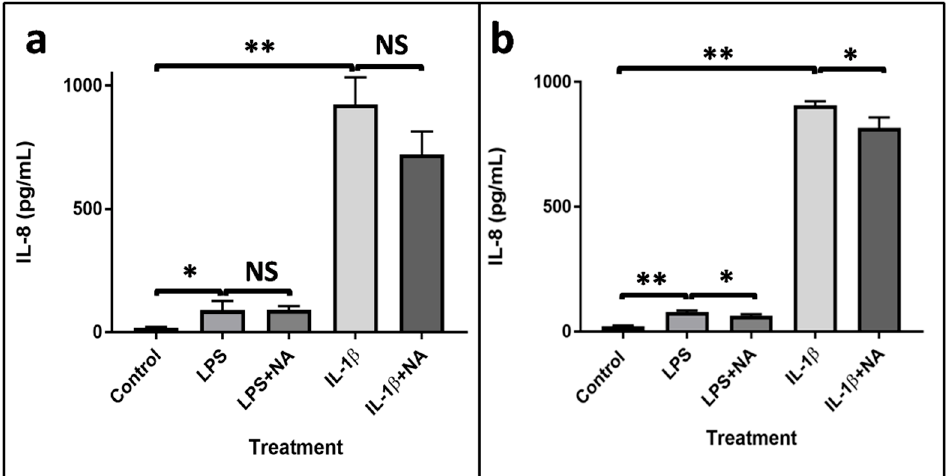
Figure 2. IL-8 measurement. Detection of IL-8 levels in Caco-2 cell culture medium after treatment with LPS (50 µ g / mL) and LPS (50 µ g / mL) + NA (100 µ g / mL) and after treatment with IL-1 β (25 ng / mL) and IL-1 β (25 ng / mL) + NA (100 µ g / mL) ( a ) and detection of IL-8 levels in Caco-2 cell culture medium after treatment with LPS (50 µ g / mL) and LPS (50 µ g / mL) + NA (200 µ g / mL) and with IL-1 β (25 ng / mL) and IL-1 β (25 ng / mL) + NA (200 µ g / mL) ( b ). Statistical analysis was performed by a Student’s t -test. Results were considered significant when * p < 0.05 and ** p < 0.01. NS = Non-significant.